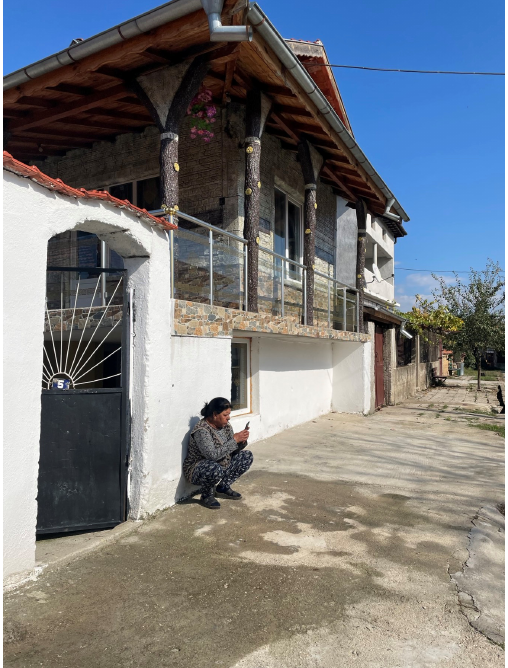
Figure 2. Roma house in the village of Panicherevo, 2021. Author: Yelis Erolova. Post terminals (ATMs) are also missing. Employees and pensioners receive